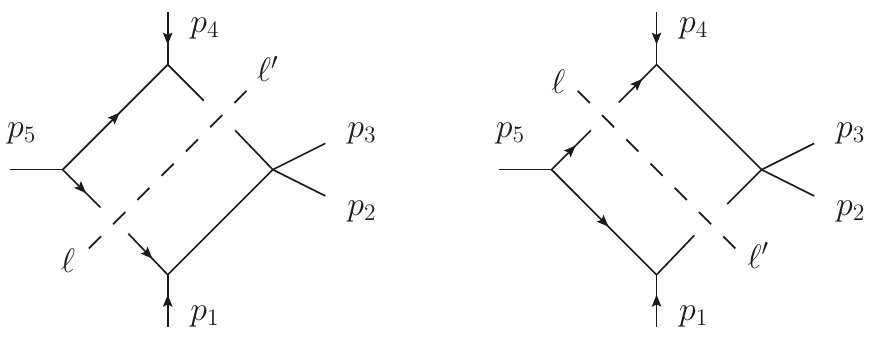
Figure 15 . Dicsontinuities of the one-mass box integral (E.1) in s 45 (left) and in s 15